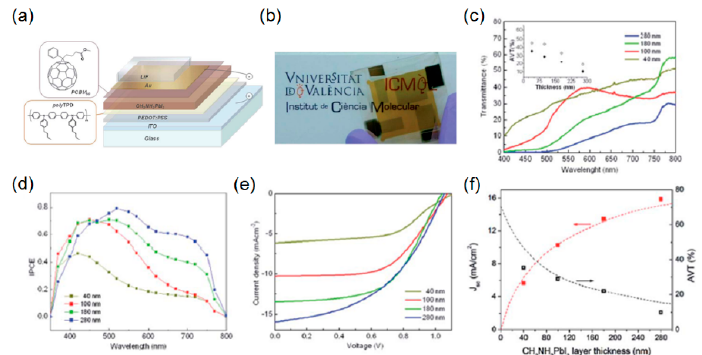
Figure 1. ( a ) Schematic layout of the semitransparent solar cell and chemical structures of the organic